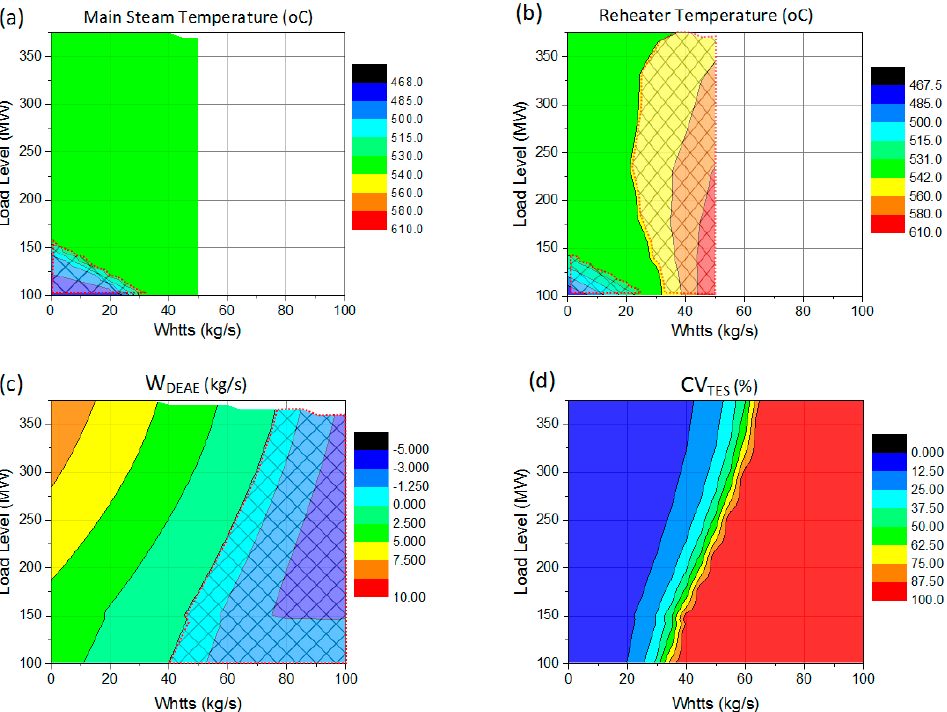
Figure 7. Simulation results: ( a ) Main steam temperature for TES charging point T1; ( b ) Reheater temperature for TES charging point T1; ( c ) Steam mass flow to deaerator ( W DEAE ) for TES charging point T3; and ( d ) TES valve opening degree ( CV TES ) for TES charging point T5. The crossed area represents the limit of the parameters’ range.